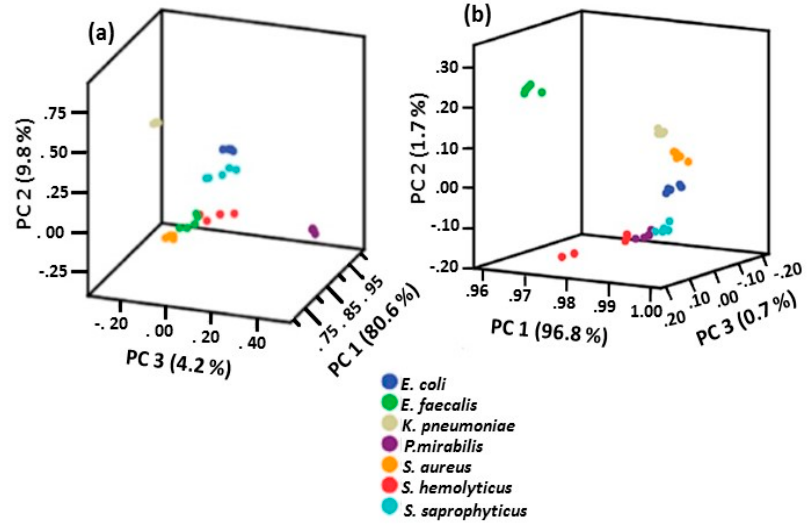
Figure 17. PCA plots of bacteria at: ( a ) 1 h; and ( b ) 24 h of incubation [71]. Reproduced with permission from Springer.